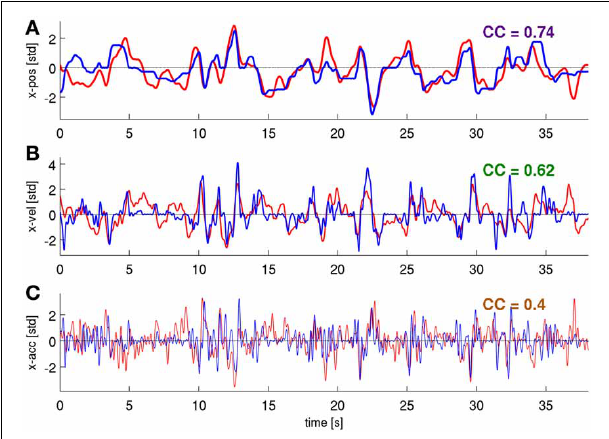
FIGURE 8 | Predictions of position, velocity, and acceleration from a representative validation fold. Using the time-frequency magnitude and phase features (DAlg3, τ = 0s). (A) position, (B) velocity, (C) acceleration, CCs are given for these individual